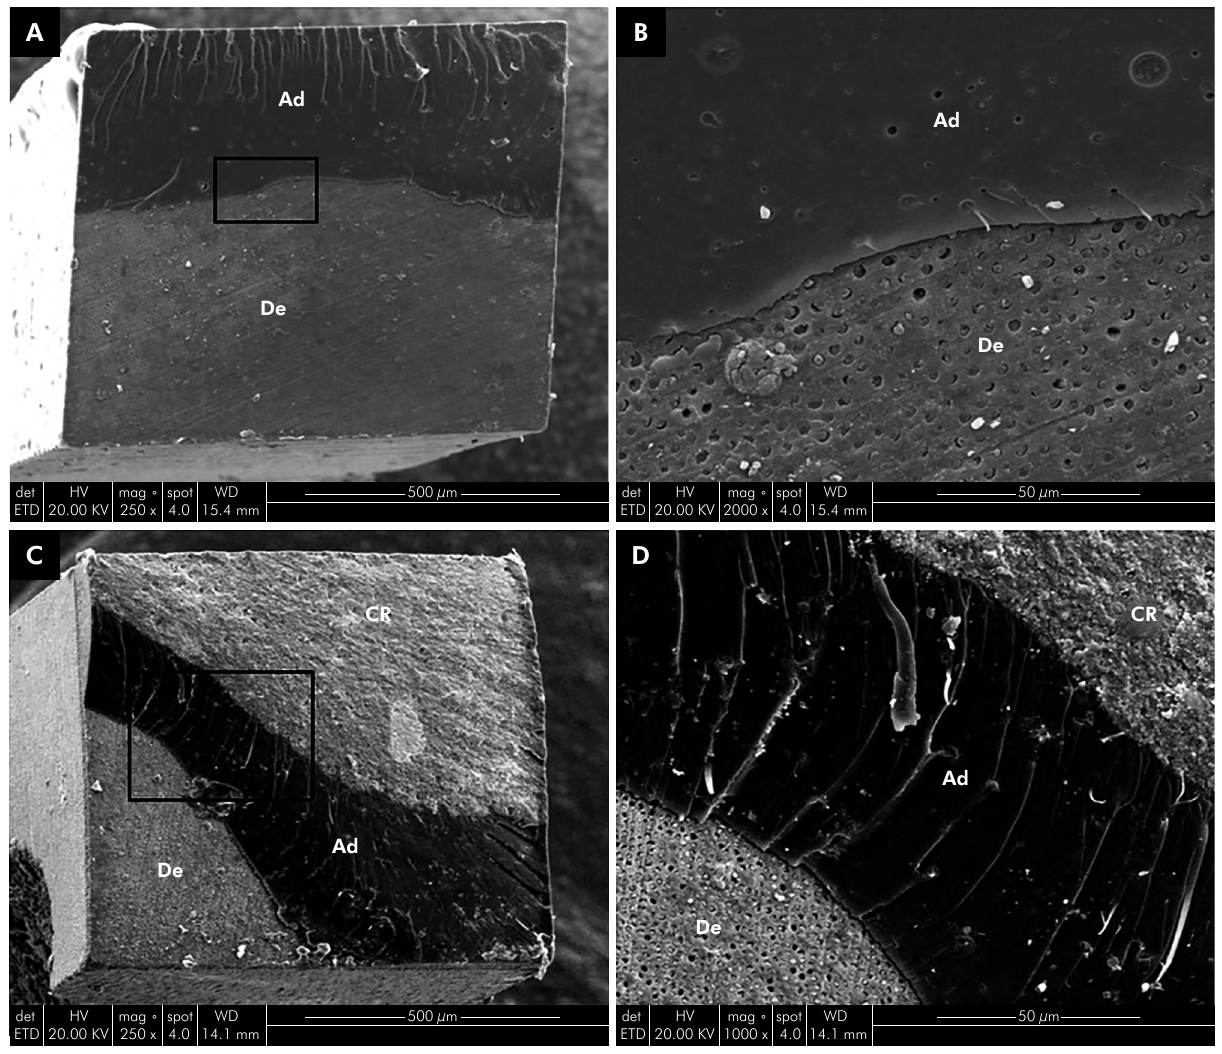
Figure 4. SEM micrographs of the predominant failures obtained after the µTBS test. (A) Interfacial failure (250x): Ad – adhesive; De – dentin. (B) Magnification of the delimited area in (A) (2,000x). (C) Mixed II failure (250x): Ad – adhesive; De – dentin; CR – composite resin. (D) Magnification of the delimited area in (C)